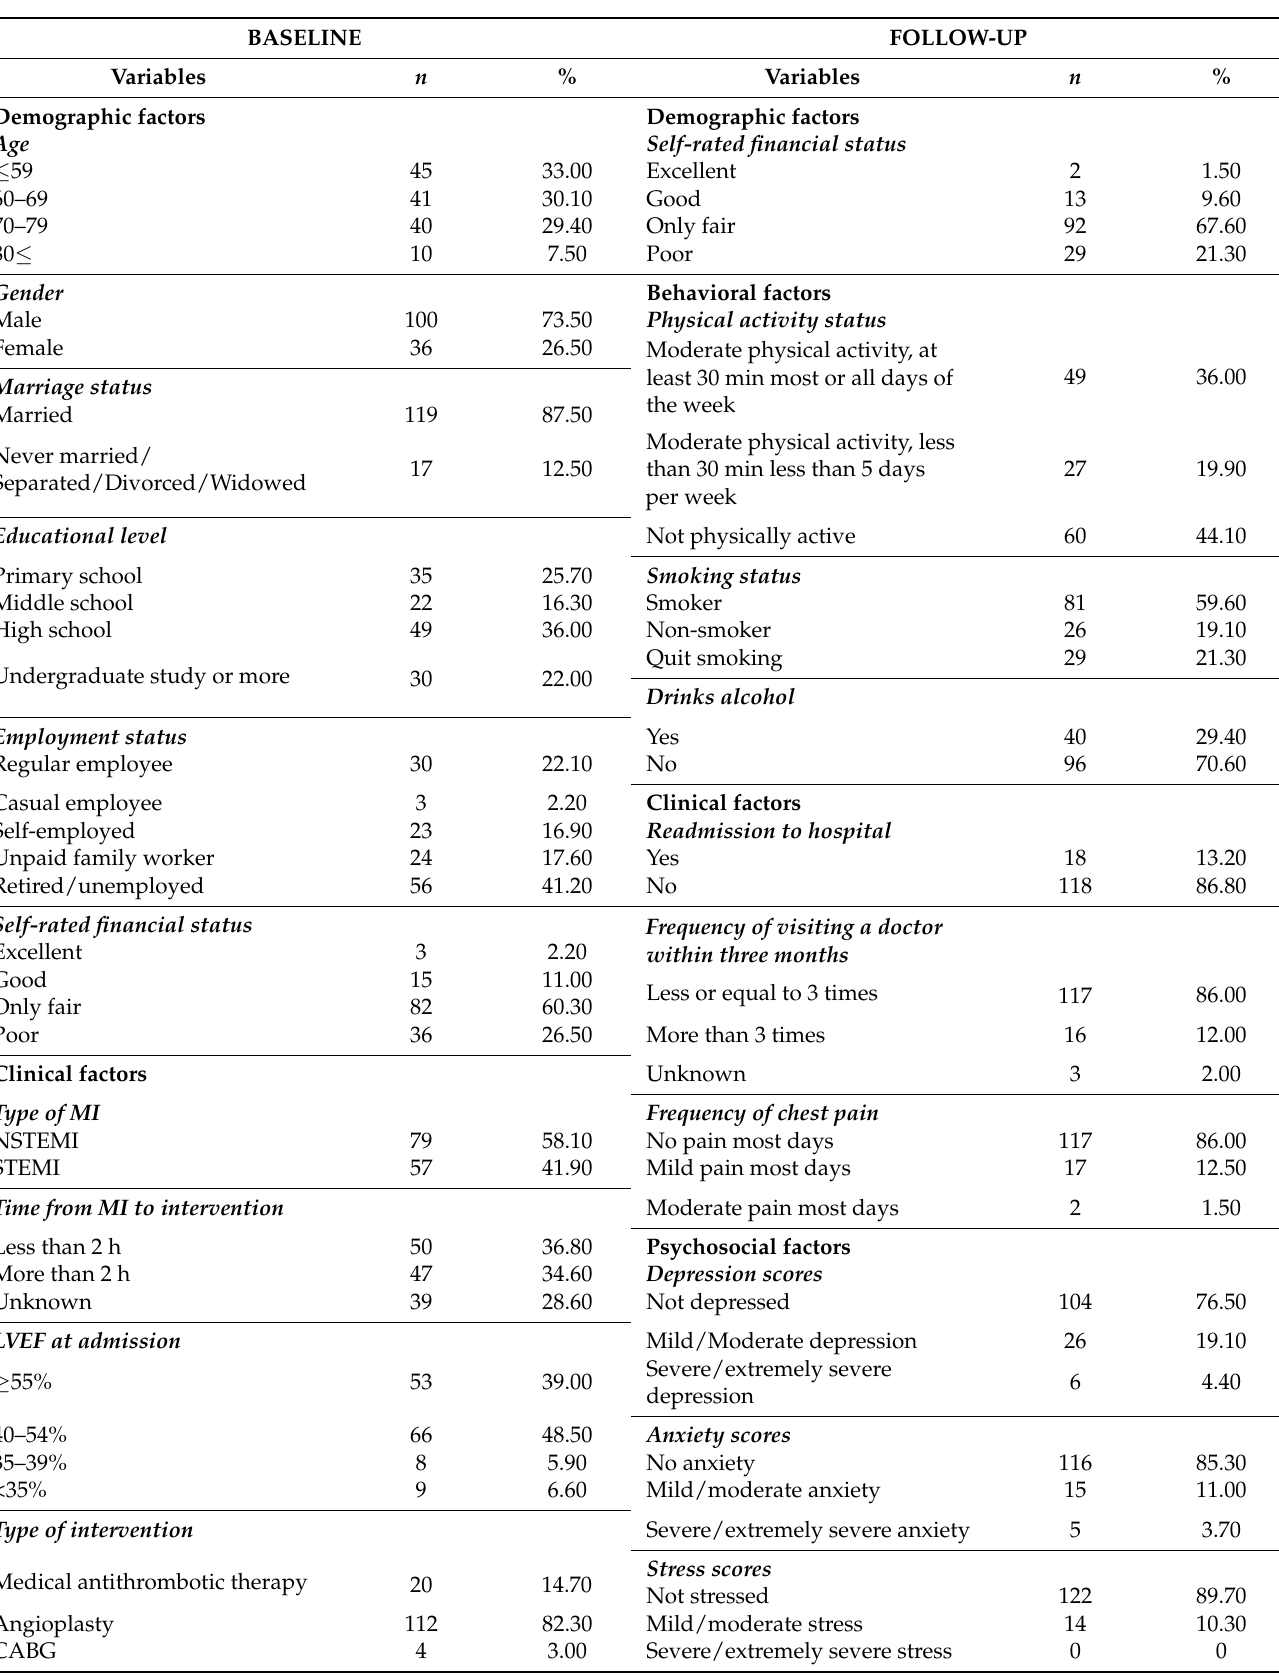
Table 1. Participants’ characteristics at baseline and three-month follow-up ( n =